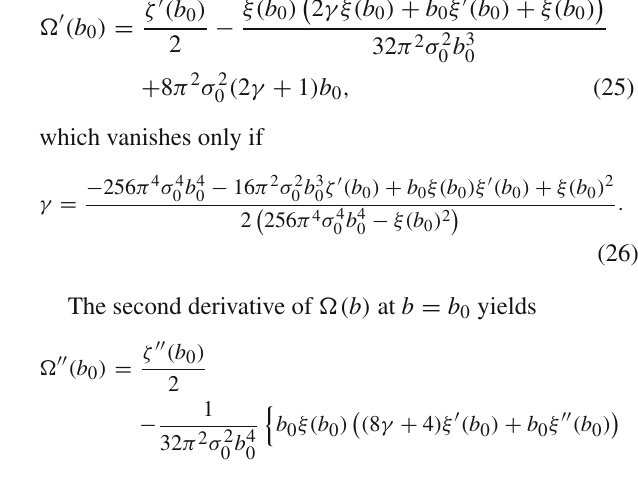
M (cid:8)(cid:8) ( b 0 ) = − 8 π p 0 + 16 πς 2 = dp / d σ | and ς 2 0